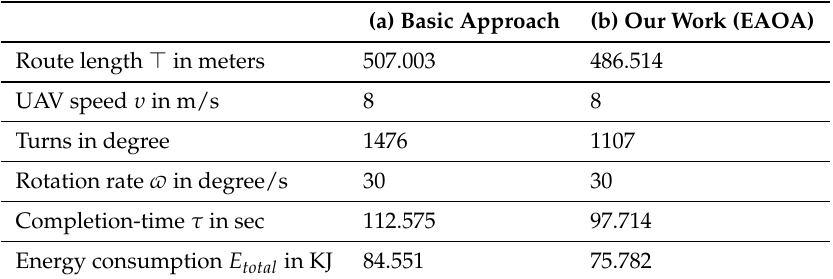
Table 1. Our basic approach vs. EAOA.